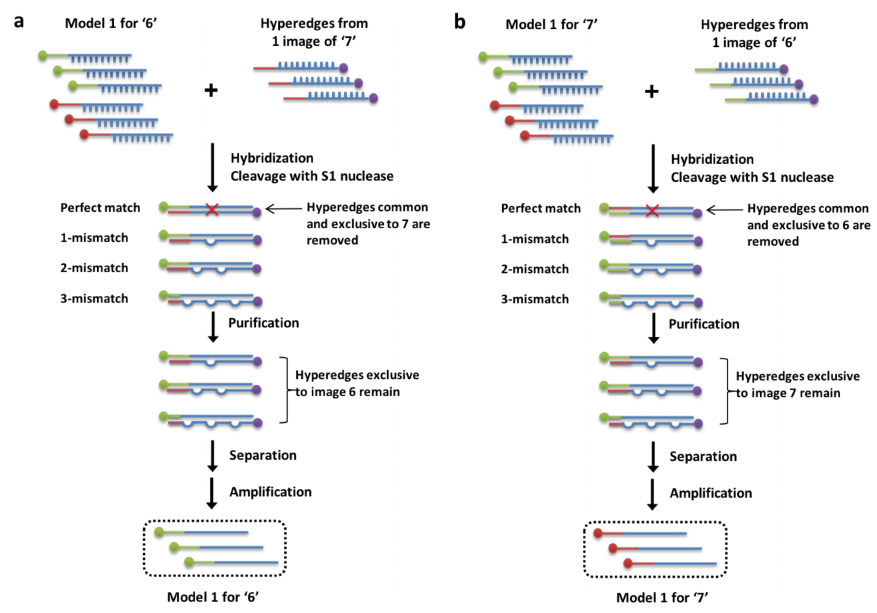
Figure 3. Overview of experimental scheme implementing molecular learning of